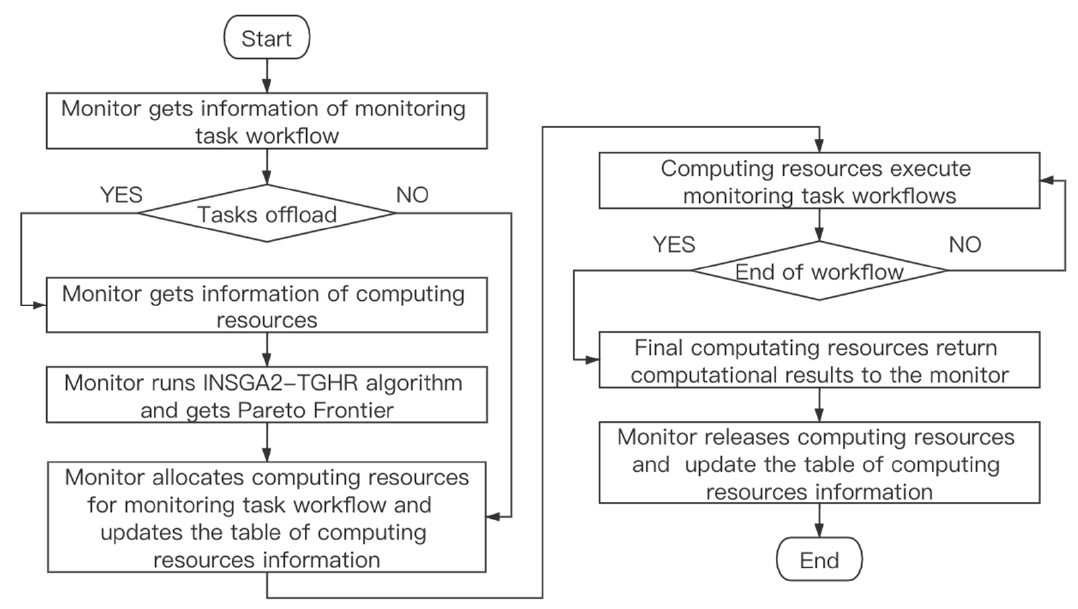
Figure 3. Trigger mechanism flow chart for INSGA2-TGHR.